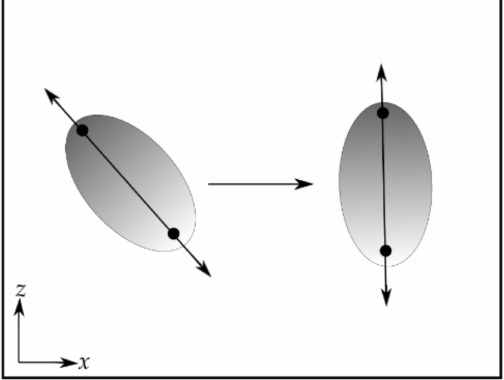
Figure 1. A schematic illustrating the rotation of a protein of interest is aligned with one of the principal coordinate axes. The protein being studied (gray ellipse) is normally in a random orientation. It should be rotated so that the direction of applied force (the lines with double arrowheads passing through the ellipses) is at least roughly parallel to one of the principal coordinate axes (the z -axis in this example). The black circles represent the site of attachment of the DNA